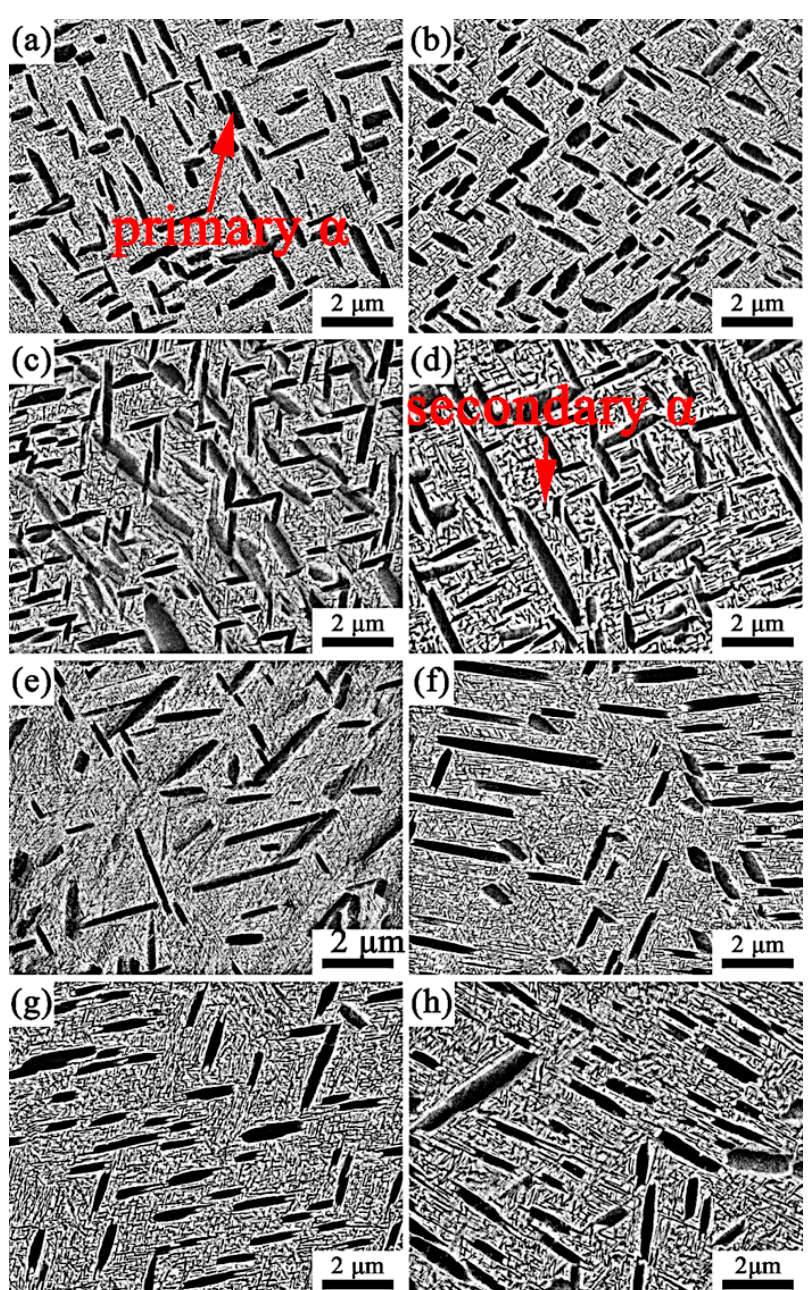
Figure 5. Microstructures of the alloy that was solution-treated for 1 h and aged for 8 h: ( a ) 760 °C + 500 °C; ( b ) 760 °C + 520 °C; ( c ) 760 °C + 540 °C; ( d ) 760 °C + 560 °C; ( e ) 780 °C + 500 °C; ( f ) 780 °C + 520 °C; ( g ) 780 °C + 540 °C; ( h ) 780 °C + 560 °C.